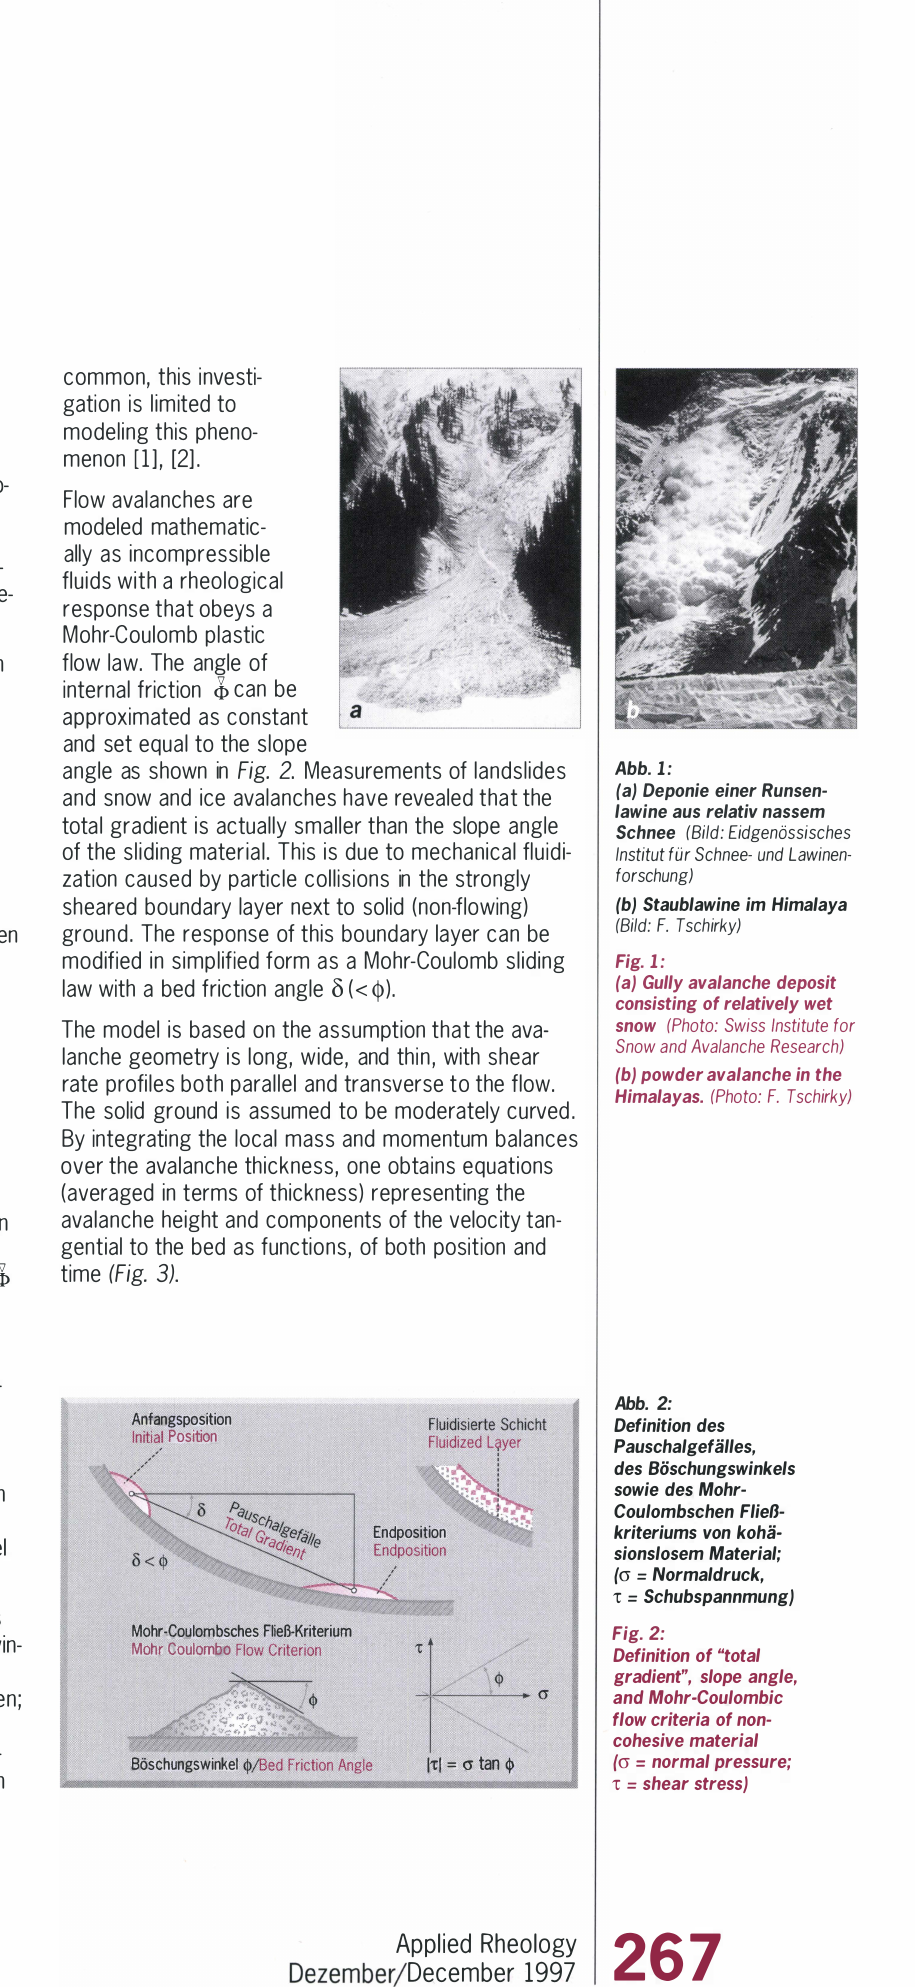
Applied Rheology